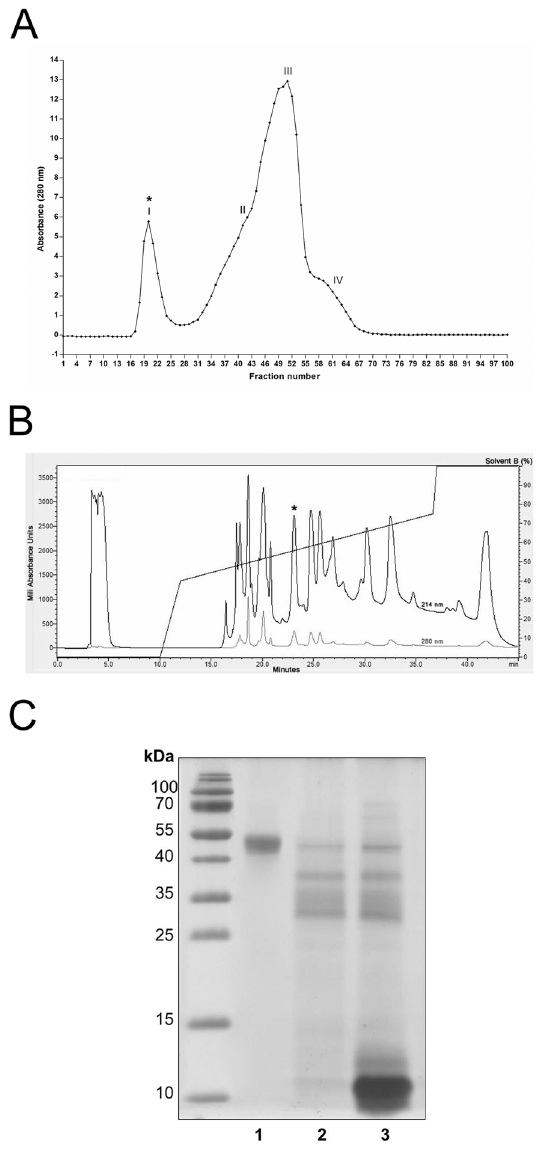
Figure 3. Purification of native hyaluronidase from Tityus serrulatus venom. (A) Gel filtration chromatogram of Tityus serrulatus venom (225 mg/ml) after fractionation through a Sephadex G-50 Fine column (100 cm 6 2.5 cm). Samples were eluted with 30% (v/v) acetic acid at a flow rate of 6 ml/h, and elution was monitored at 280 nm. Fractions were assayed for hyaluronidase activity. Only fraction I (marked with an asterisk) was active. (B) Reversed-phase liquid chromatogram of gel filtration fraction I after fractionation through an analytical C8 column (300 A˚, 5 m m, 4.6 mm 6 250 mm). Samples were eluted with a gradient of solution B (0.1% (v/v) TFA in ACN; 0–40% (v/v)